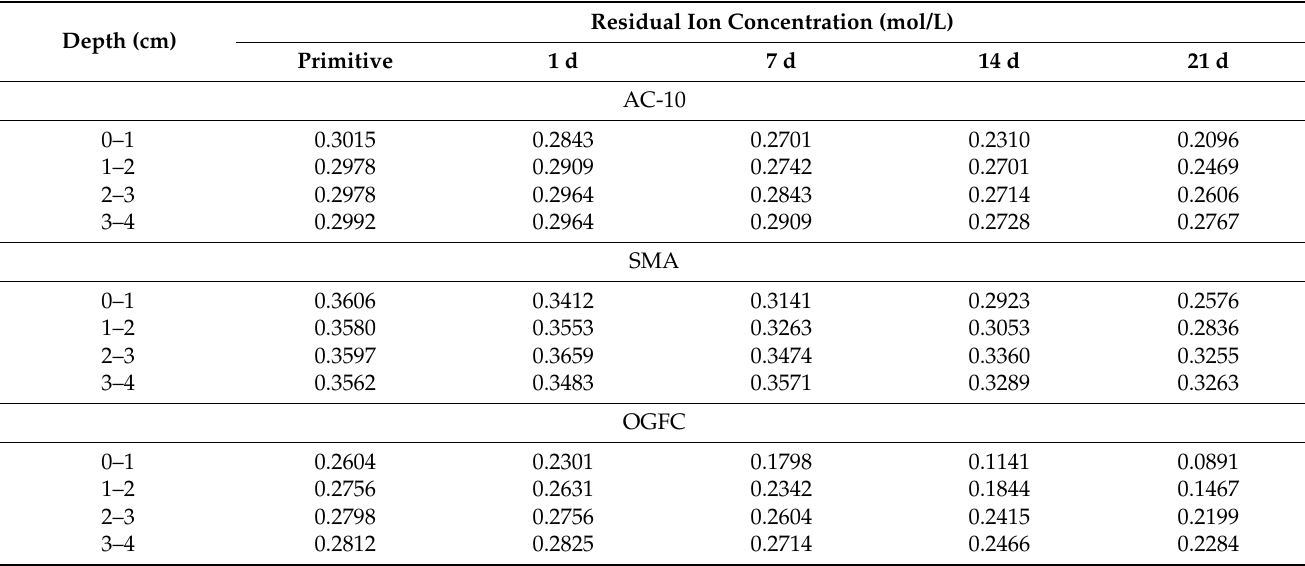
Table 9. Cumulative ion releasing process of different types of salt-storage